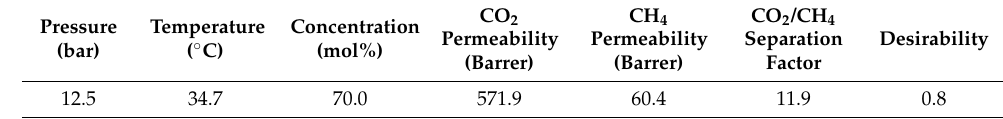
Table 6. Experimental conditions generated by the DOE software and responses.